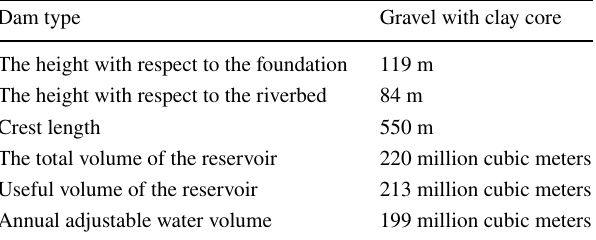
Table 1 Some specifications of Urmia Shaharchay dam (Urmia Shah- rchay dam Project, 2019)